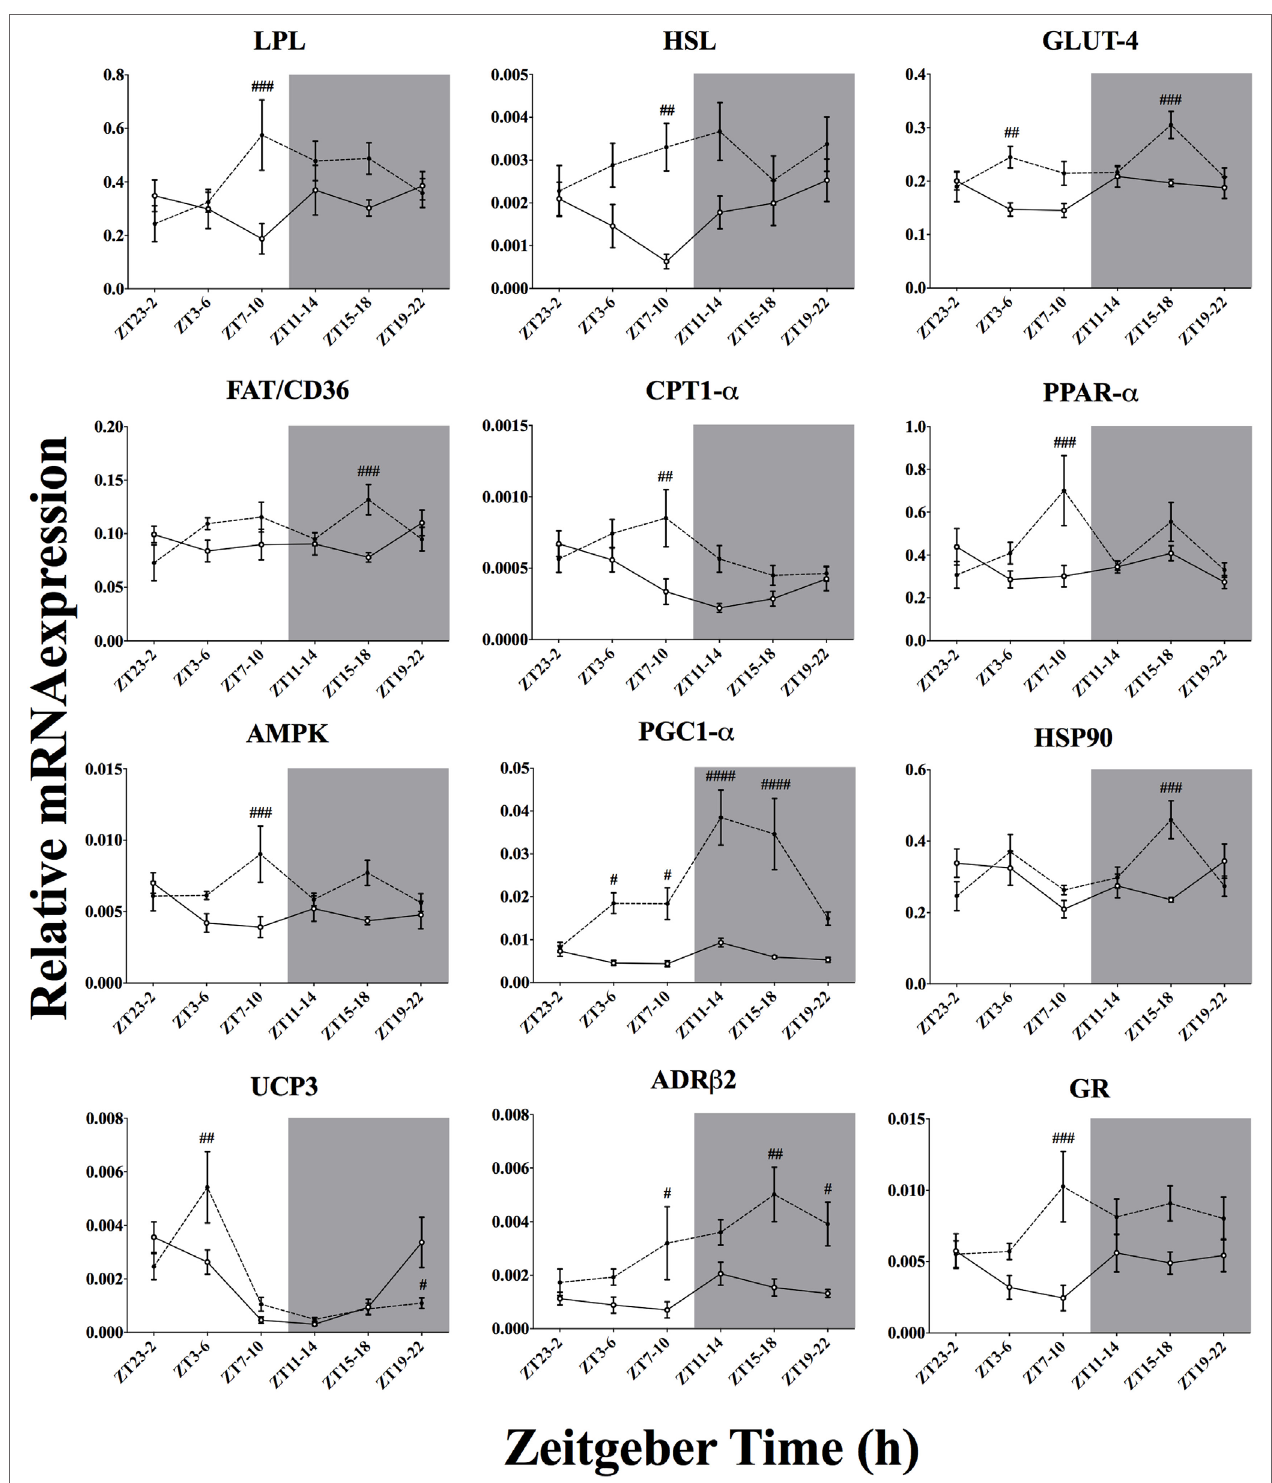
FigUre 8 | Effect of time­of­day on metabolic gene expression in soleus muscle after exposure to environmental cooling. Light phase began at Zeitgeber Time 0 (ZT0) and dark phase (shaded areas) began at ZT12. Results are presented as mean ± SEM. # indicates differences between control and cold conditions, p < 0.05 . n = 5–7/group/ZT. Data for CREB, PGC1­ β , PPAR­ γ , UCP2 , CIRBP, CPT- β , NAMPT­1, FOXO­1, ACC2, CamK2a, and mTOR are not shown (refer to Table 5 for